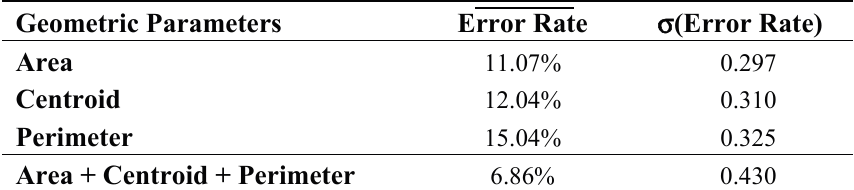
Table 11. Classification error rates using geometric